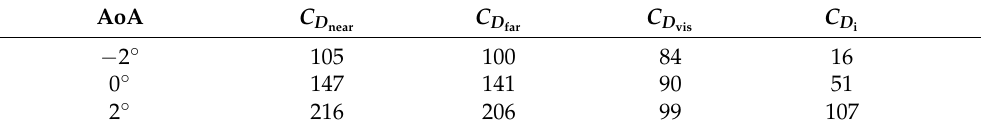
Figure 21. IB-OB-1 configuration at Re ∞ = 16.6 × 10 6 , M ∞ = 0.480. Breakdown of the drag polars with spurious drag detection on medium mesh levels; induced drag computed by Maskell’s formula. Table 9. IB-OB-1 configuration at Re ∞ = 16.6 × 10 6 , M ∞ = 0.480. Drag breakdown with spurious drag detection on medium mesh levels; induced drag computed by Maskell’s formula.